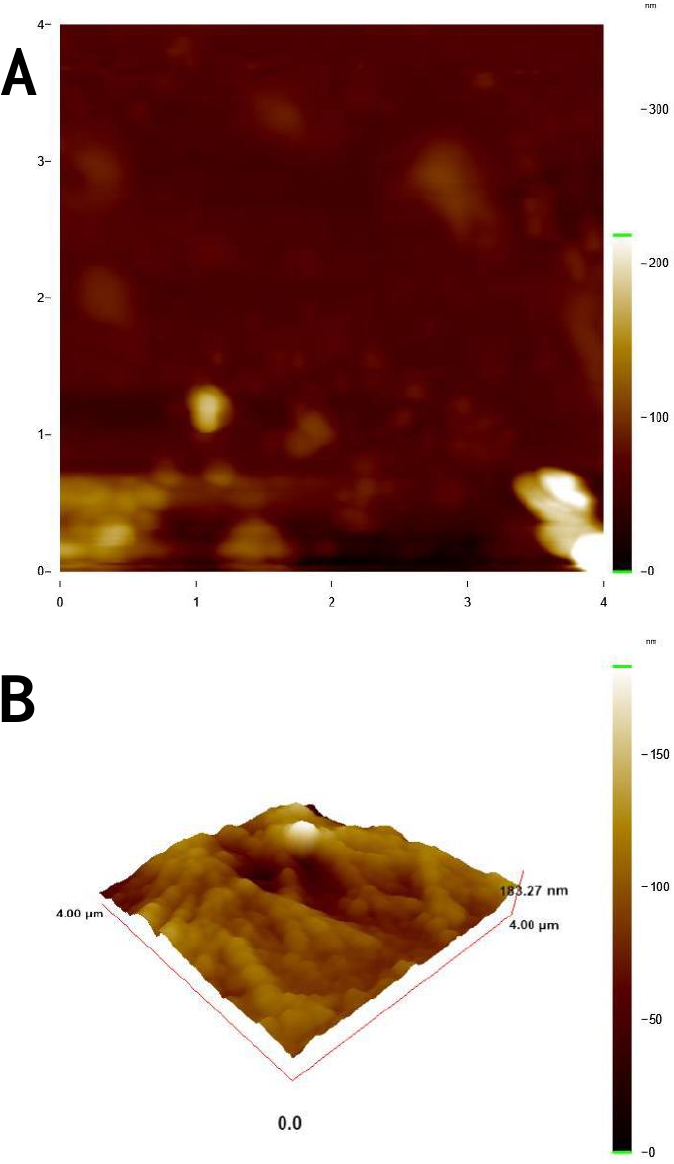
Figure 1. AFM topographical images ( A ) Clean glass surface, ( B ) Multilayer ct-dsDNA 3D view 4 × 4 μm scan size.